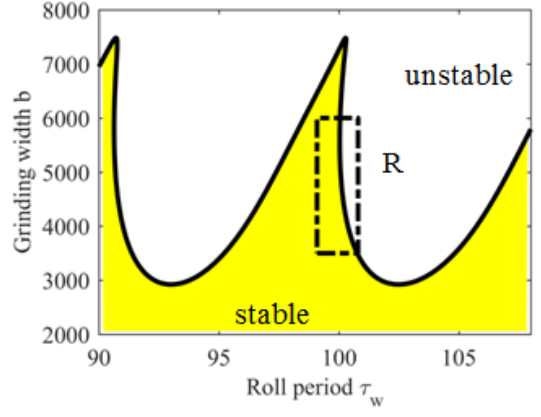
Fig. 3. Conventional stability boundary of roll